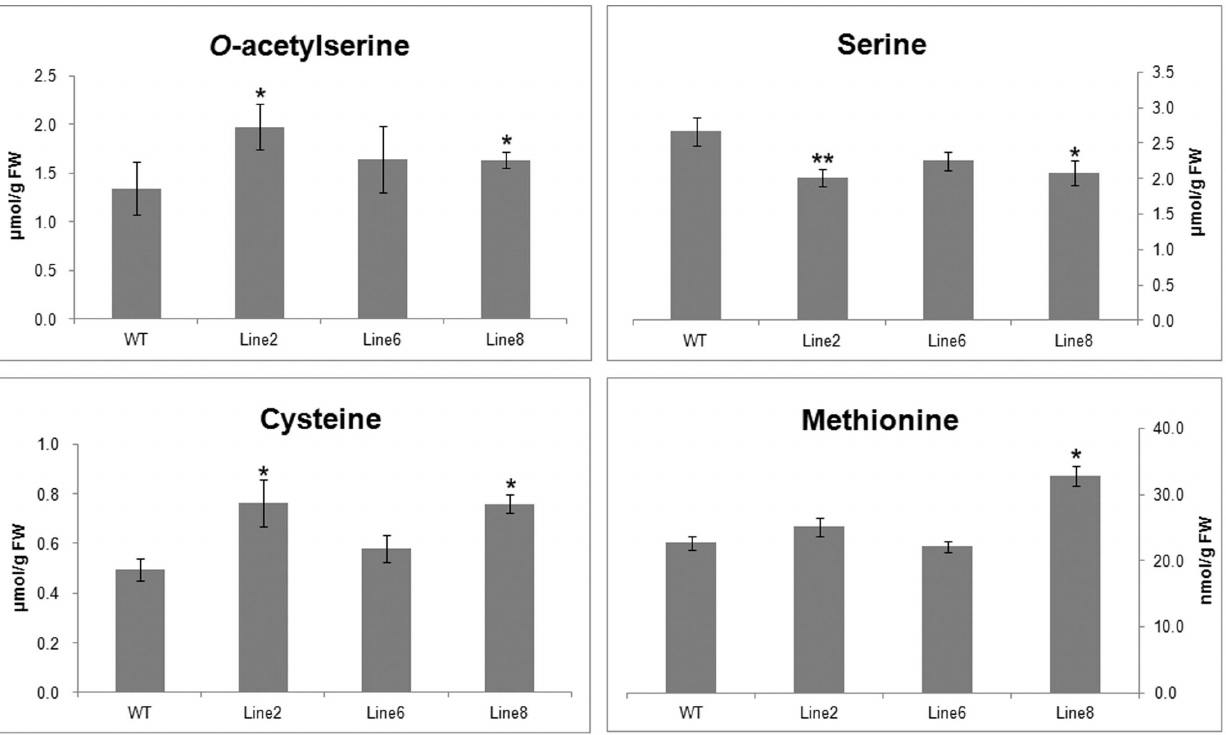
Figure 5. OAS and free amino acid levels in wild-type and transgenic plants. Lane WT: wild-type line; Lane 2,6,8: Line 2,6,8 transgenic alfalfa lines. Each bar represents the mean of three biological replicates 6 SE. * represents statistically significant differences (P , 0.05). ** represents statistically significant differences (P , 0.01).